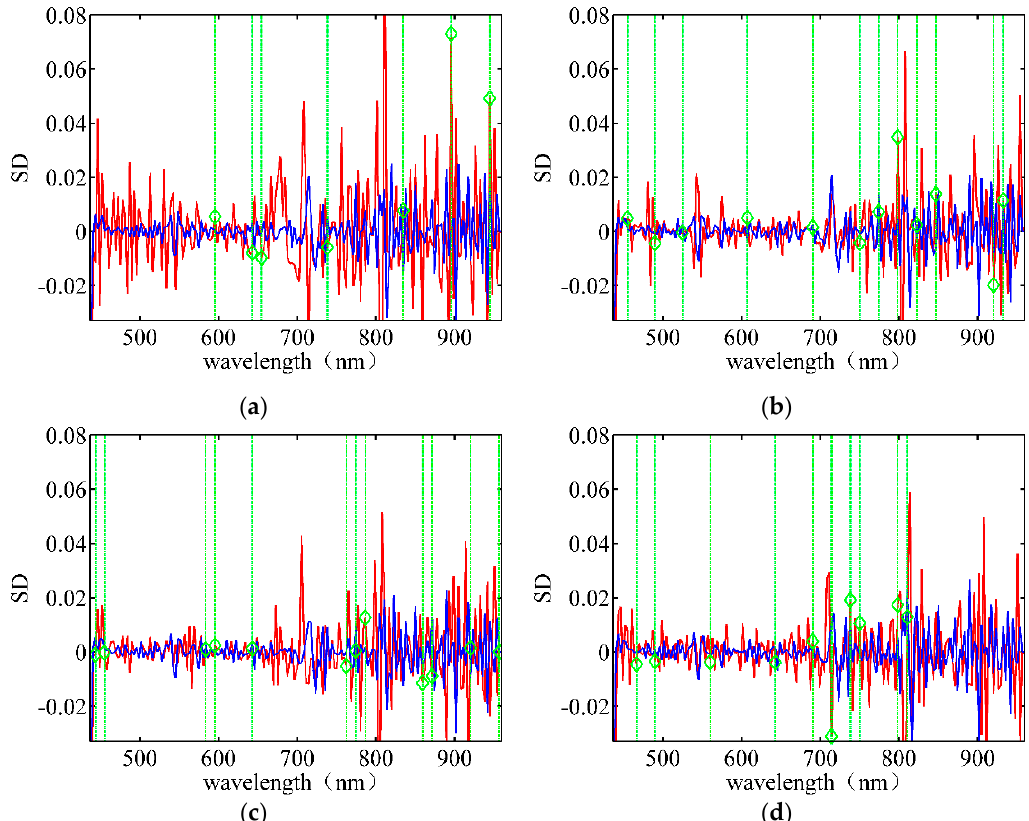
Figure 9. Wavelength band selection using SD data for different rice varieties under the optimal 𝜆 . ( a ) Huguangxiang; ( b ) Xiangwan Japonica; ( c ) Huanghuazhan; ( d ) Japonica 530.